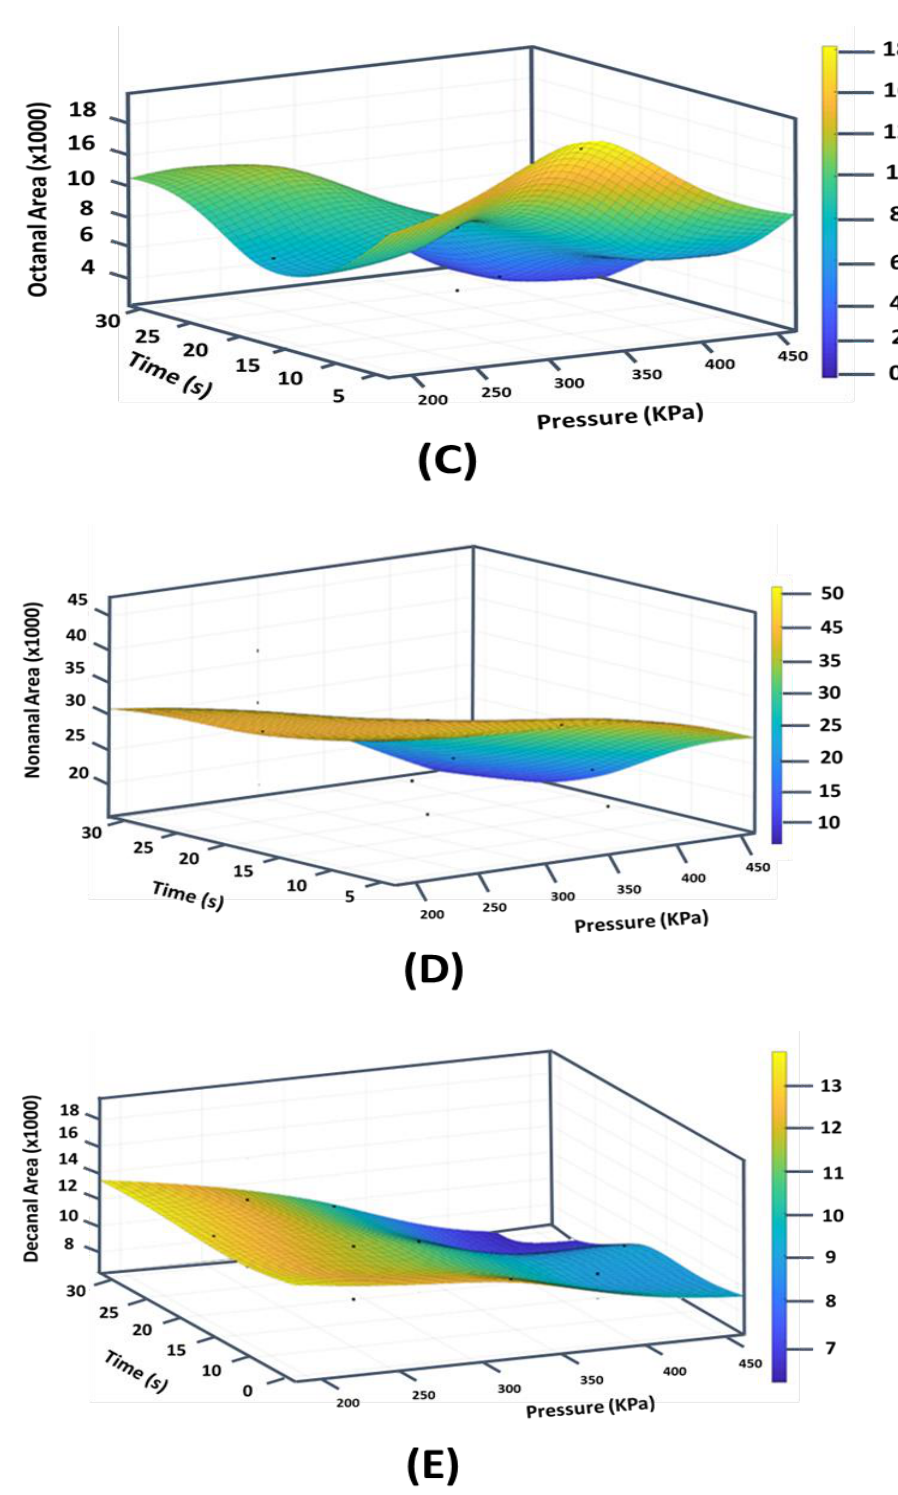
Figure 6. Response surface curves of residual aroma compounds versus treatment time and pressure for several cycles C = 6 of palm oil (( A – E ) respectively for E-2-hexenal, heptanal, octanal, nonanal, and decanal).